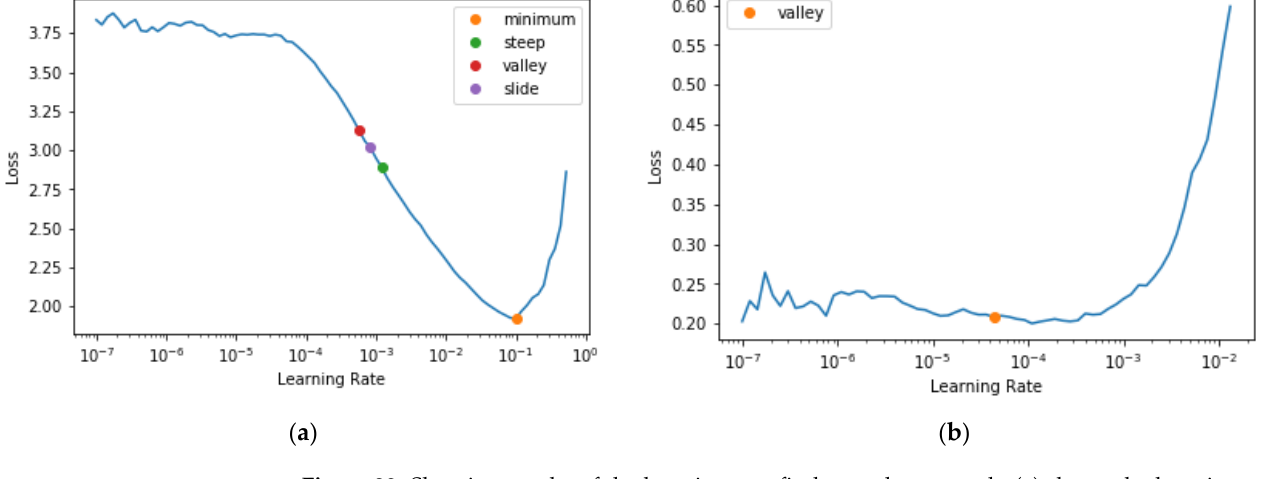
Figure 20. Showing results of the learning rate finder on the network: ( a ) shows the learning rate find result before unfreezing for the network of depth 152; ( b ) shows the result of the second learning rate find after unfreezing the model and training briefly on the first selected learning rate.